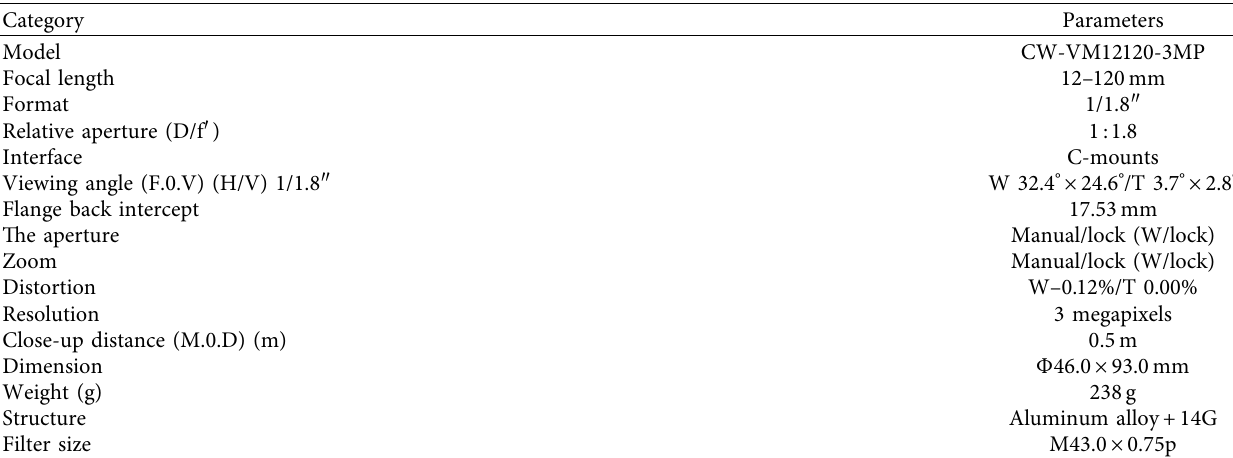
Figure 5: Technical Table 1: Specification parameters of the lens.